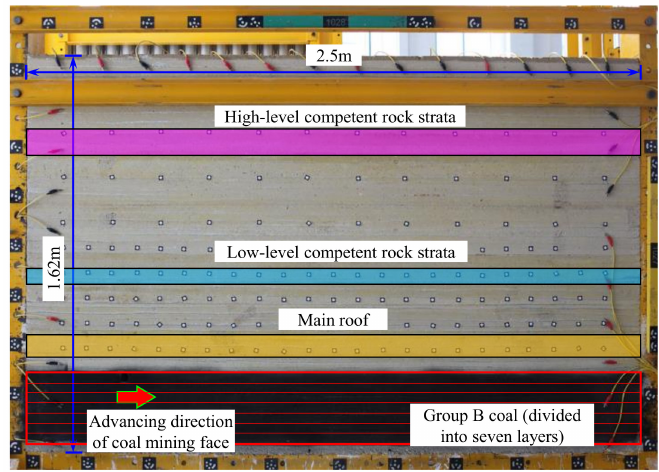
Figure 3. The physical model built for the analyses of ultra-thick coal seam